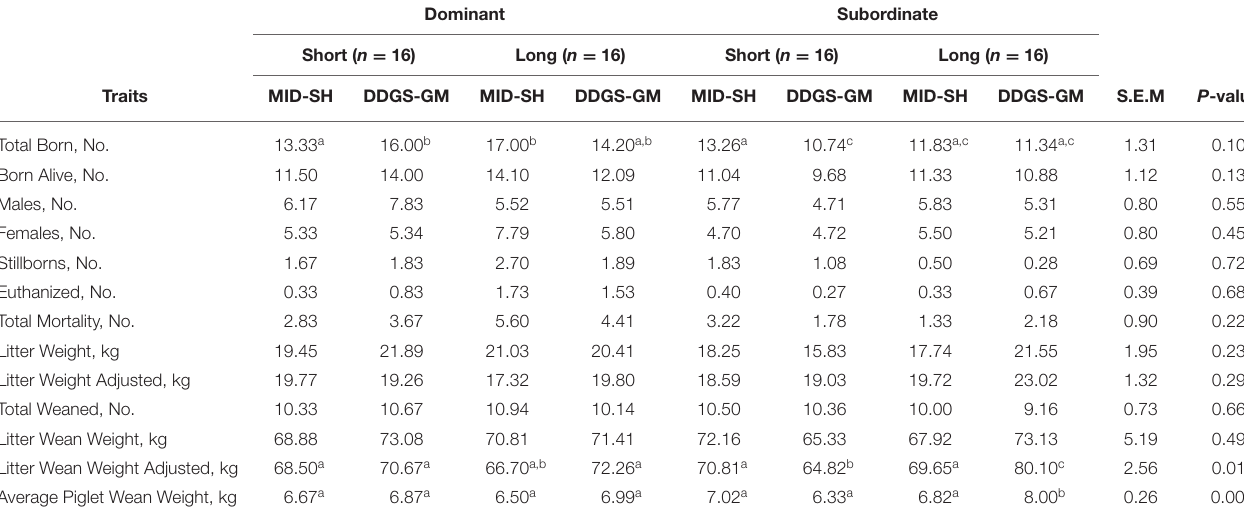
TABLE 6 | Interactive effects of social status on mean litter-related traits for group-housed gestating sows fed one of two dietary fiber treatments and housed in pens equipped with either short or long length feeding barriers ( n = 64 total sows). Dominant Subordinate Short ( n = 16) Long ( n = 16) Short ( n = 16) Long ( n = 16) Traits MID-SH DDGS-GM MID-SH DDGS-GM MID-SH DDGS-GM MID-SH DDGS-GM S.E.M P -value Total Born, No. Born Alive, No. Males, No. Females,